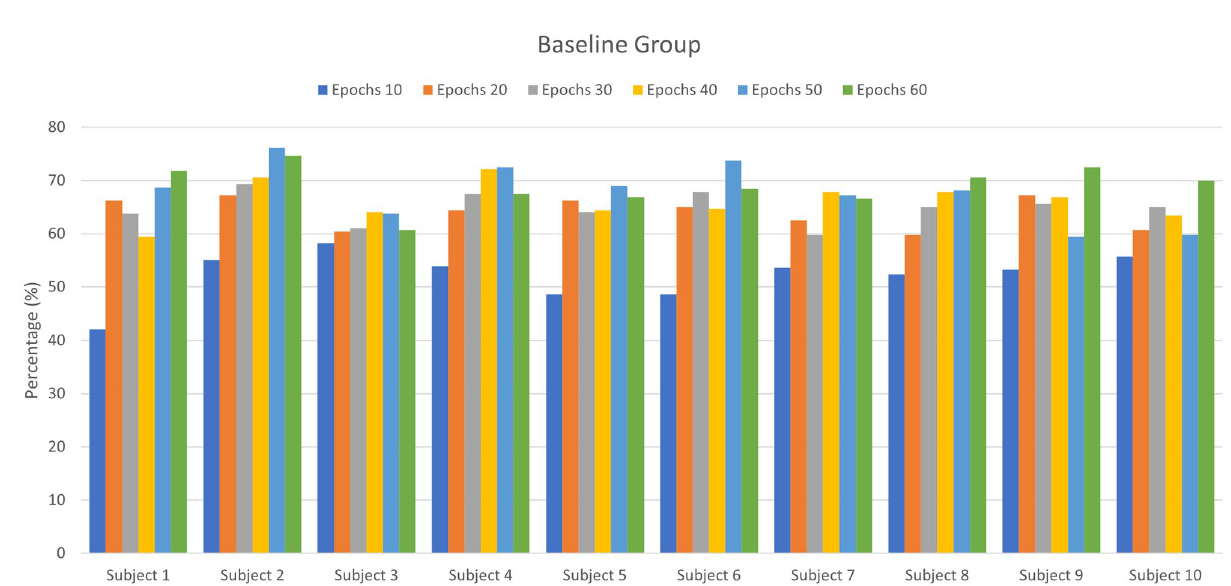
Figure 6. The accuracies using CNN model on baseline group subjects at epochs from 10 up to